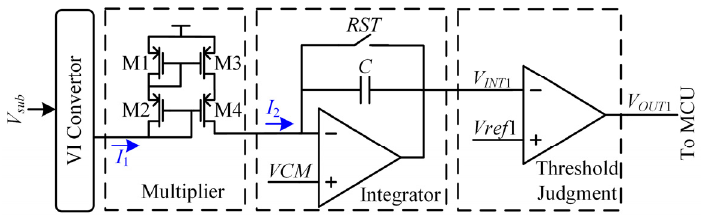
Figure 5. The scheme of the proposed RX judgment circuit.